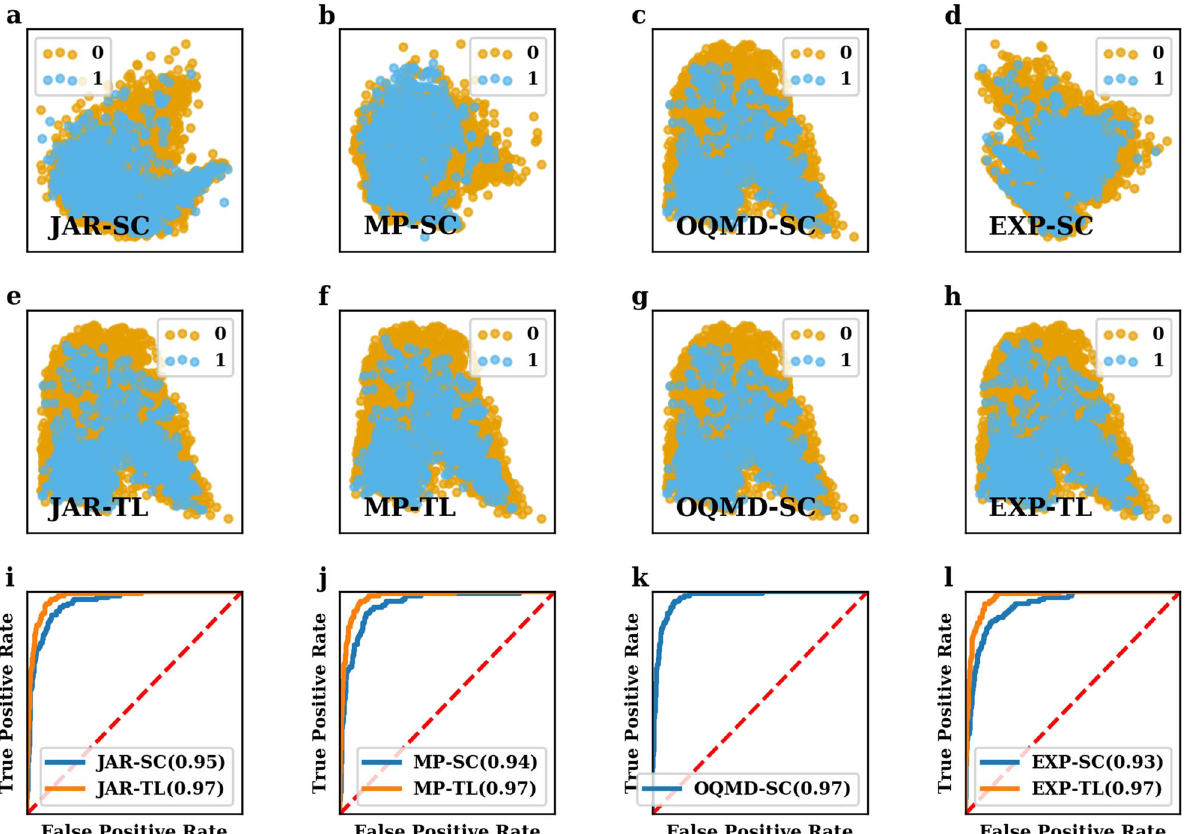
The original version of the Supplementary Information associated with this Article contained an error in Supplementary Fig. 1, Supplementary Fig. 2 and Supplementary Fig. 3, which contained duplicate entries in the Experimental data